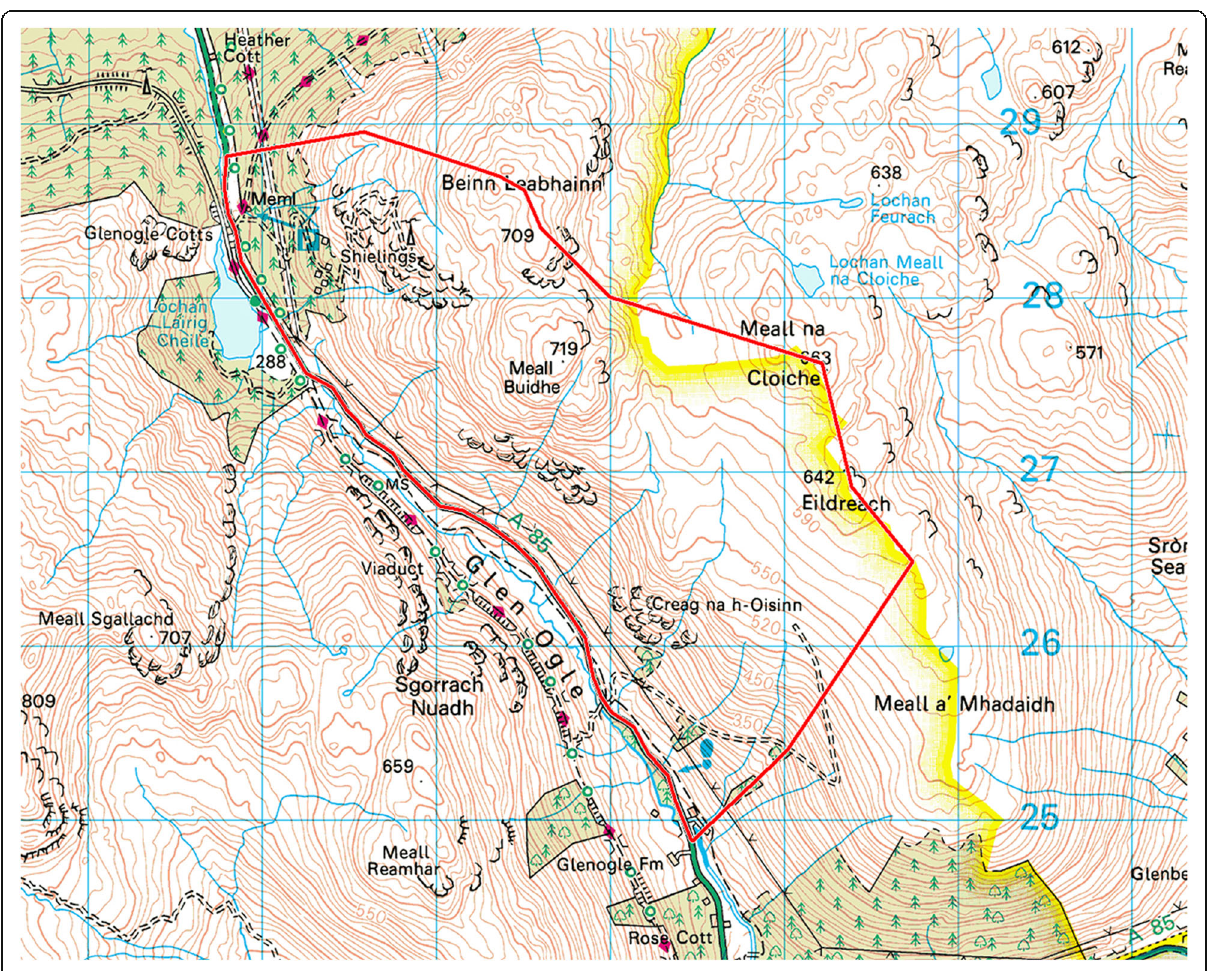
Fig. 7 Location plan of the A85 Glen Ogle study area outlined in red (Ordnance Survey 1:50,000, not to scale). Reproduced by permission of Ordnance Survey, on behalf of HMSO,© Crown copyright and database rights, 2020. All rights reserved. Ordnance Survey Licence number